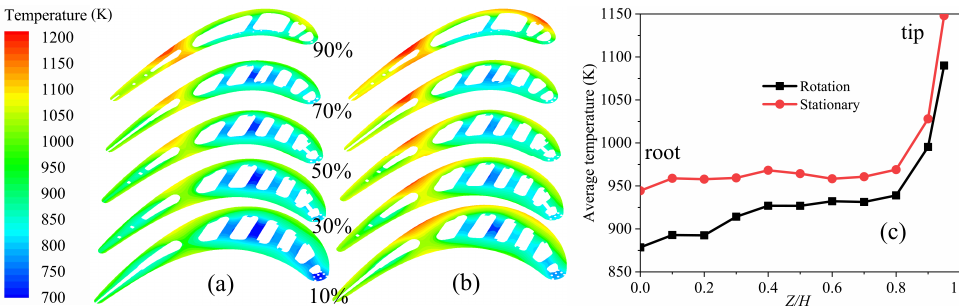
Figure 8. The temperature distribution of the blade spans: ( a ) rotating condition; ( b ) stationary condition; ( c ) average temperature along the blade span.